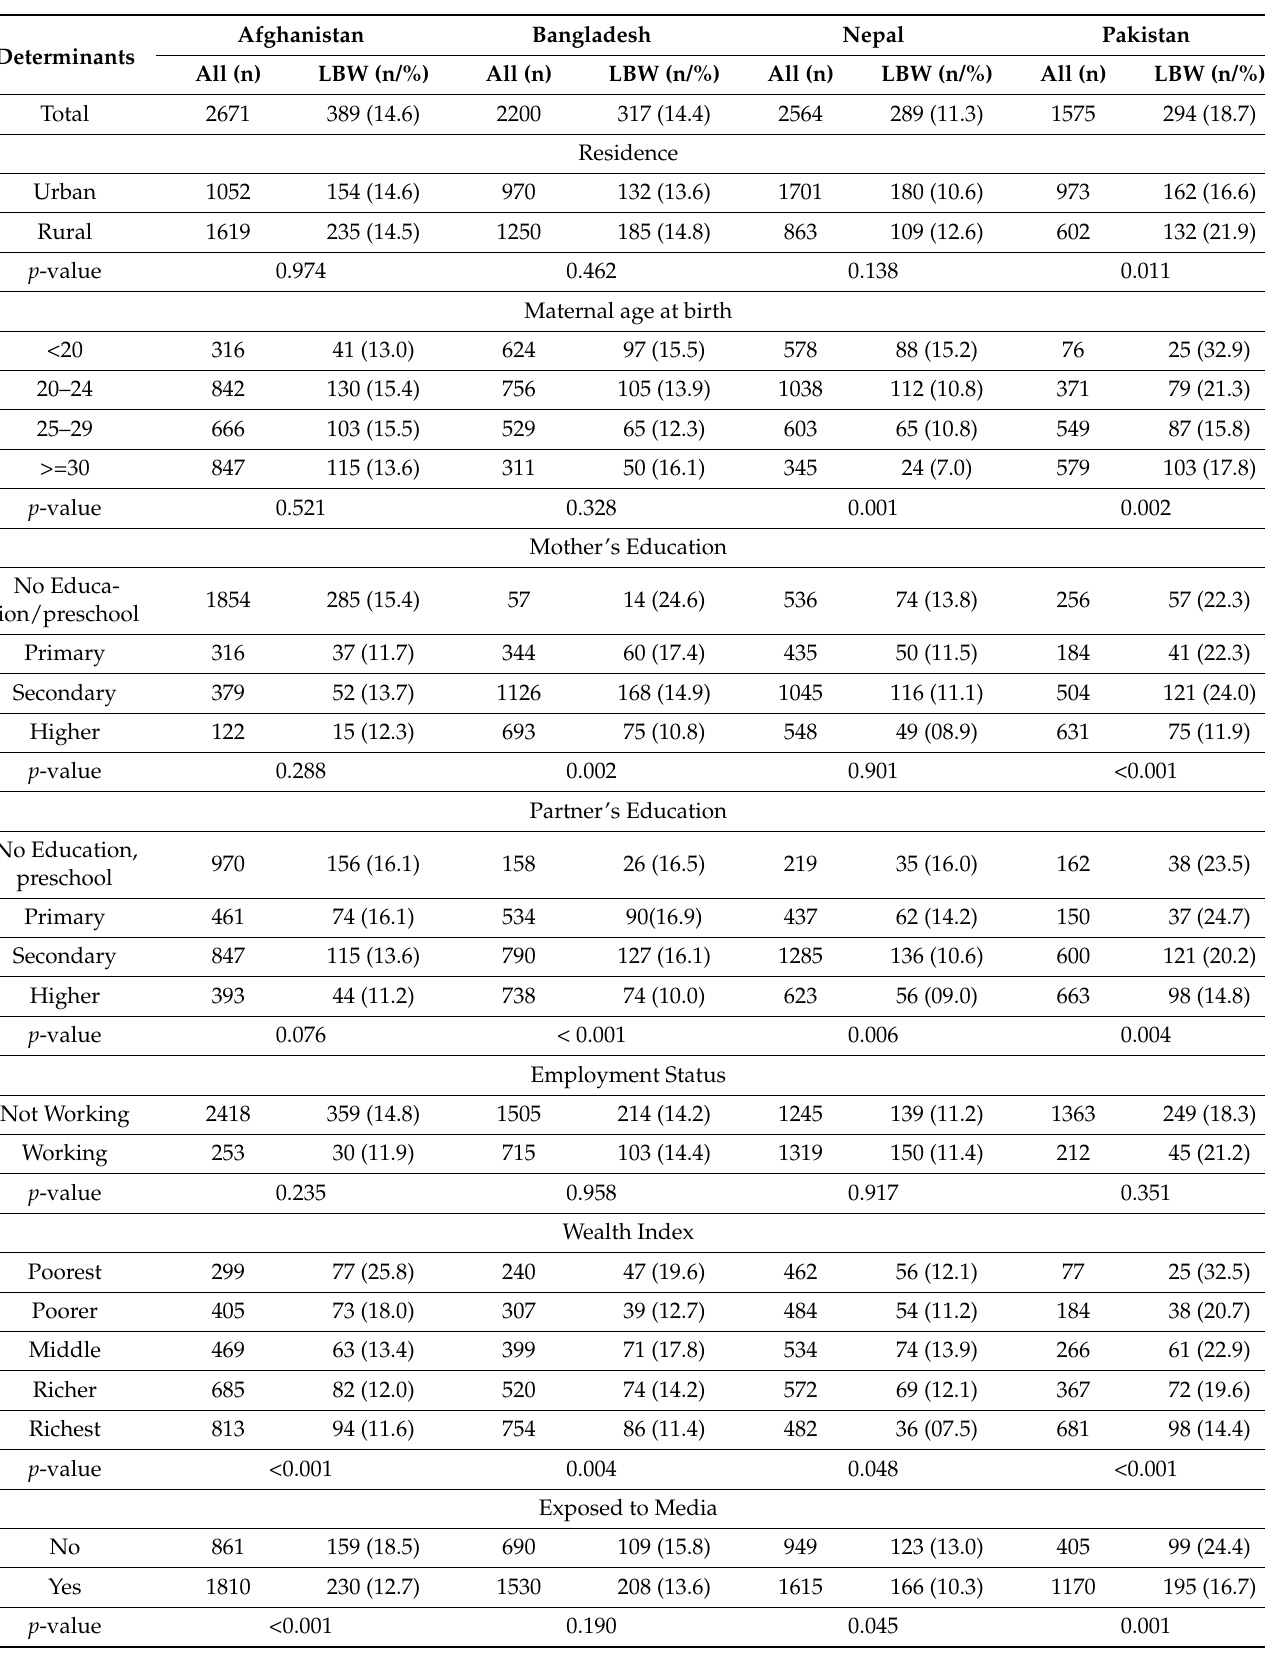
Table 1. Distribution of sociodemographic factors and proportion of children with LBW in Afghanistan, Bangladesh, Nepal and